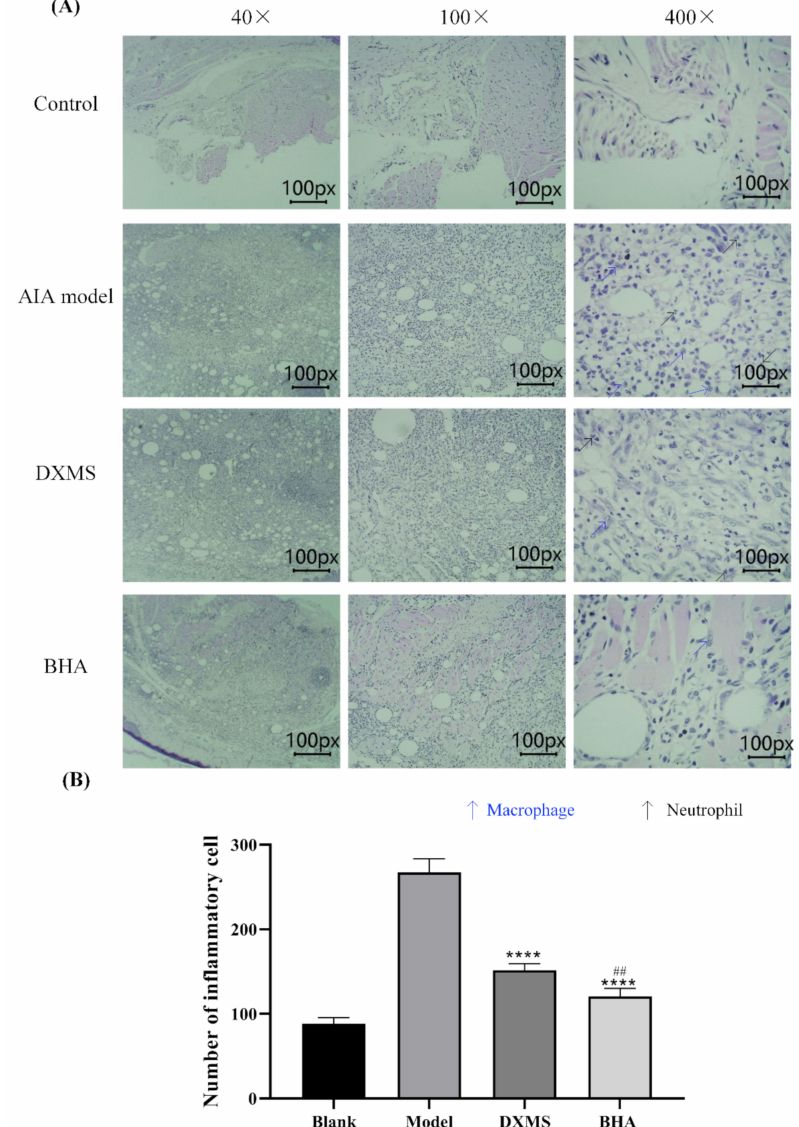
Figure 5. ( A ) Histopathological assessment of the paw tissues of rats. The rats were sacrificed at the endpoints of these experiments. The paw tissues of these rats were then excised and fixed in 4% paraformaldehyde. The histological sections were stained with hematoxylin and eosin. Microscopy at magnifications of 40 × , 100 × and 400 × are shown for typical areas for each of the five groups. The control group possessed normal paw tissue. Increased inflammatory cell infiltration was observed in the paw tissue of FCA-injected AIA rats in the model group. Treatment with DXMS and BHA partially prevented inflammation in the paw tissues of AIA rats. The black arrow indicates neutrophile, and the blue arrow indicates macrophage. ( B ) Quantification of the pro-inflammatory cells. Data are expressed as mean ± SEM ( n = 5), **** p < 0.0001 relative to the model group; ## p < 0.01 was relative to the DXMS treatment